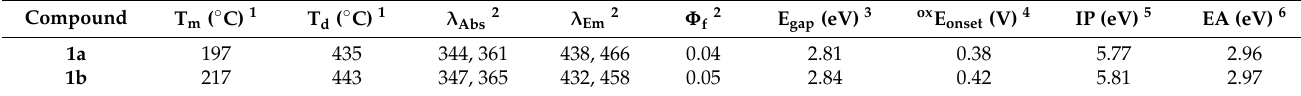
Table 2. Thermal, optical and electrochemical properties of compounds 1a – b .